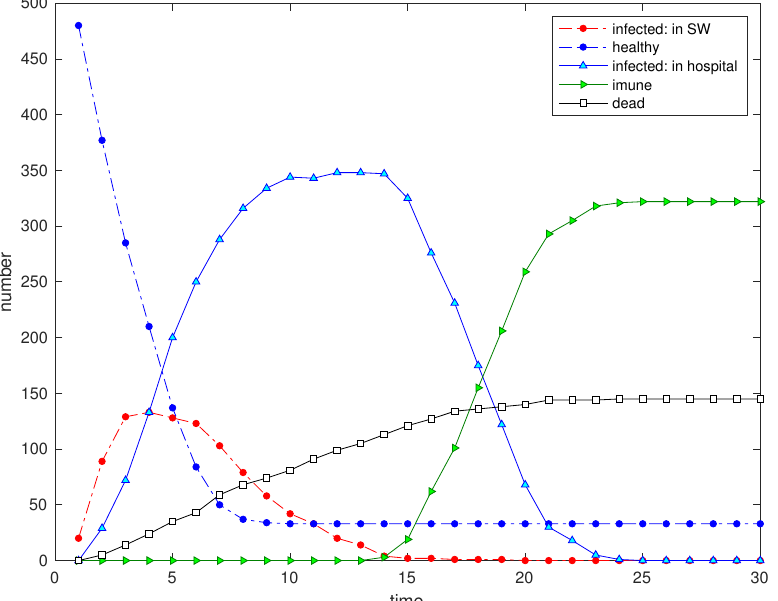
Figure 18. Scenario S 11 : Time evolution of the 5 state variables for n i = 20 ( N = 500, D = 0.07, δ = 0.1, p 1 = 0.1, p 2 = 0.9, p 3 = 0.7, α = 2 and N h → ∞ ). Table 2 lists the parameters and the obtained values of the indices for the seven new